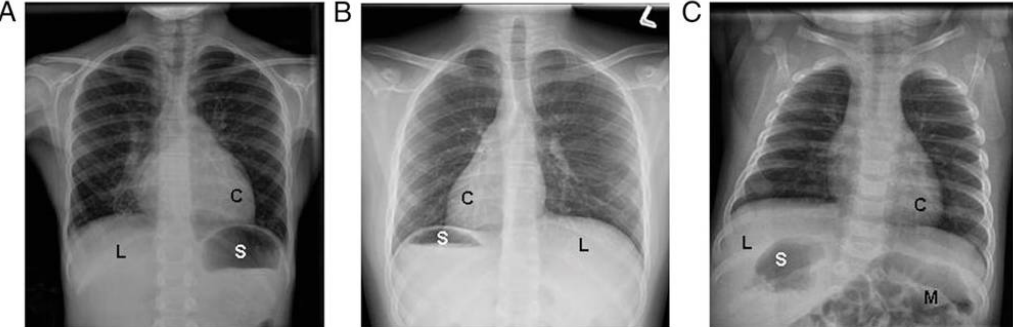
Figure 1. Examples of laterality defects on radiology imaging: ( A ) situs solitus, ( B ) situs inversus totalis, and ( C ) situs ambiguus. (C = cardiac apex; L = liver; M = intestinal malrotation; S = stomach). Reprinted with permission from ref. [11]. Copyright 2014 Shapiro AJ, Davis SD, Ferkol T, Dell SD, Rosenfeld M, Olivier KN, et al.